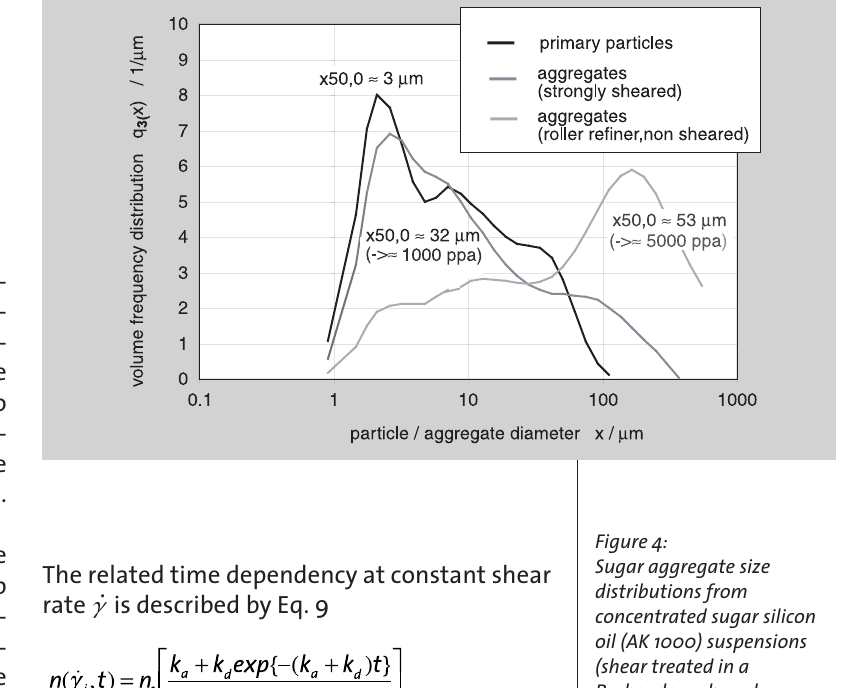
Figure 4: Sugar aggregate size distributions from concentrated sugar silicon oil (AK 1000) suspensions (shear treated in a Brabender s -kneeder ( f S ≈ 0.65, g · ≈ 120 1/s, 25°C) presence of lecithin emulsifier, [13]).